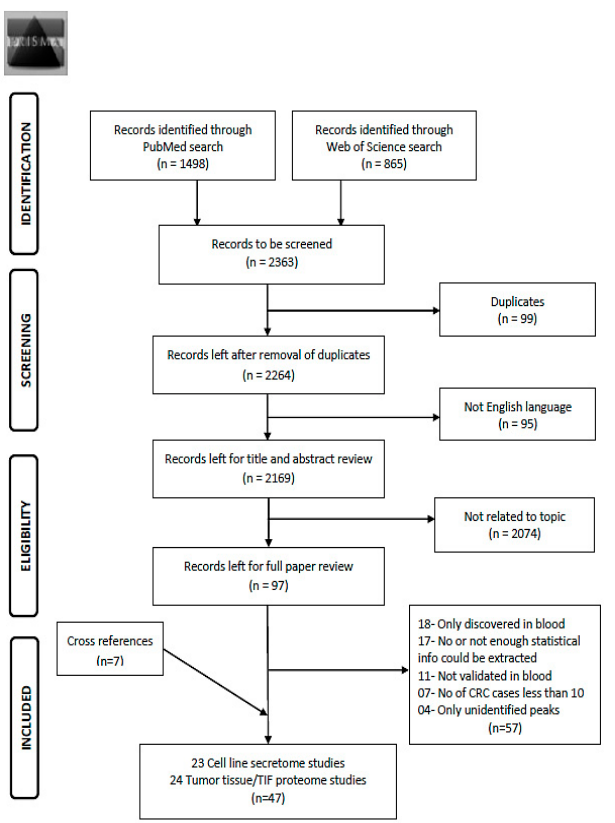
Figure 1. Preferred reporting items for systematic reviews and meta-analysis (PRISMA) Flow diagram for literature search process for records identified via PubMed and Web of Science database [20]. Abbreviations: TIF: tissue interstitial fluid; CRC: colorectal cancer.